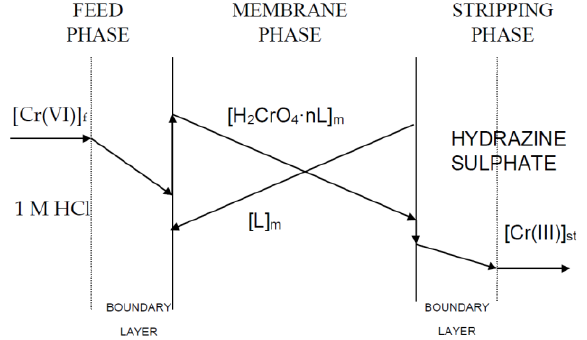
Figure 1. Concentration profiles of the chromium and phosphine oxide (L) species in the metal-transport system. Feed phase: f. Membrane phase: m. Stripping phase: st. Stoichiometric coefficient: n (determined in Section 3.3).